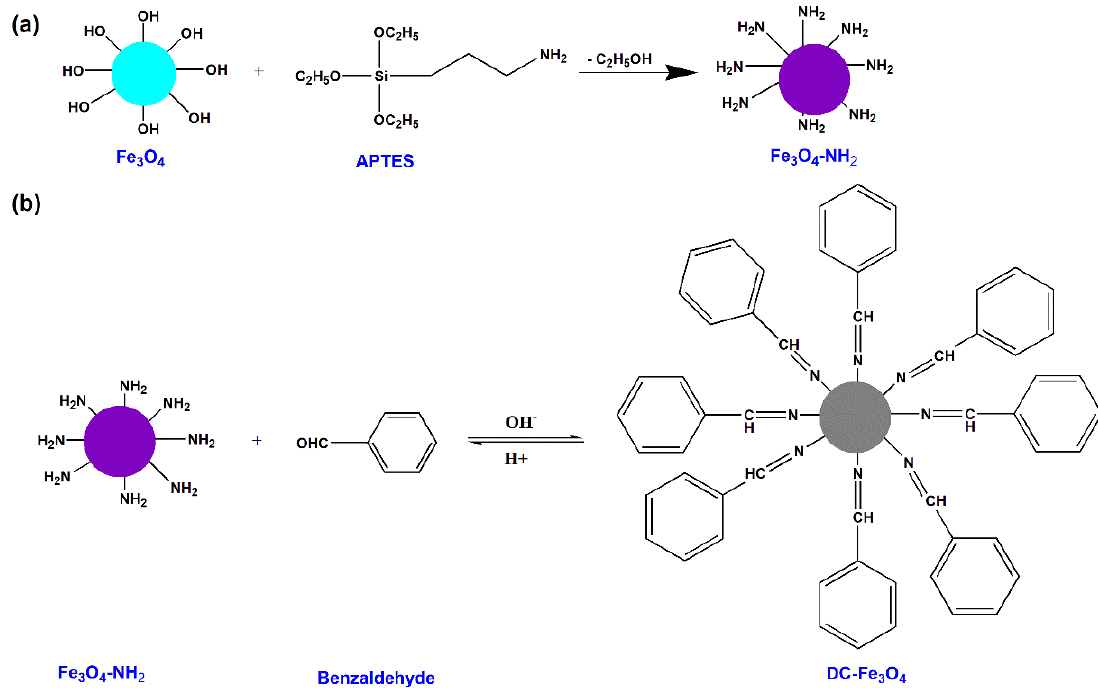
Figure 1. Schematic illustration of the synthesis of Fe 3 O 4 -NH 2 ( a ) and DC-Fe 3 O 4 ( b ).